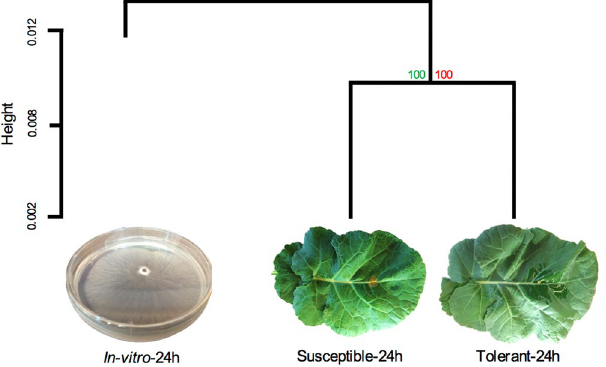
Figure 1. Growth and penetration of S . sclerotiorum in-vitro (PDA) and in-planta ( Brassica napus cv. Westar (Susceptible) and ZhongYou821 (Tolerant)) with a hierarchical clustering analysis of global gene activity based on FPKM transcript abundances and a minimum detection value of 1 FPKM. Approximately unbiased (au) values found in green and bootstrapping p-values (bp) in red. Height represents correlation value between sub-